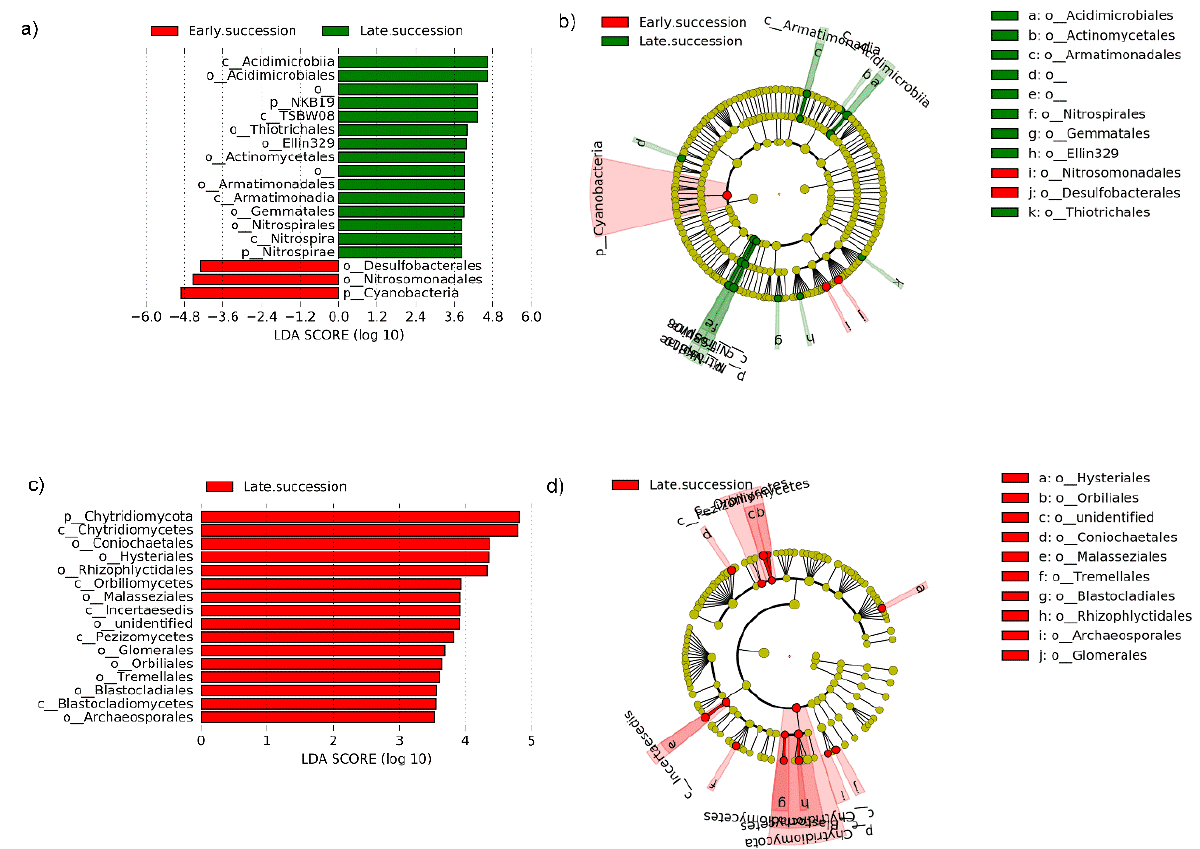
Figure 5. Cladogram indicates the phylogenetic distribution of microbial lineages under different succession periods, and each circle’s diameter is proportional to the given taxon’s relative abundance. Different colors represent different treatments and dominant taxonomy groups. ( a ) Indicator bacteria with linear discriminant analysis (LDA) scores of 2 or greater in bacterial communities under different succession periods. ( b ) Phylogenetic distribution of bacterial lineages under different succession periods. ( c ) Indicator fungi with LDA scores of 2 or greater in fungal communities under different succession periods. ( d ) Phylogenetic distribution of fungal lineages under different succession periods.